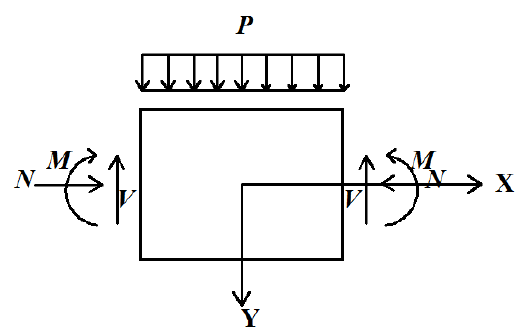
Figure 3. The loading and inner force distribution of the tunnel lining section.